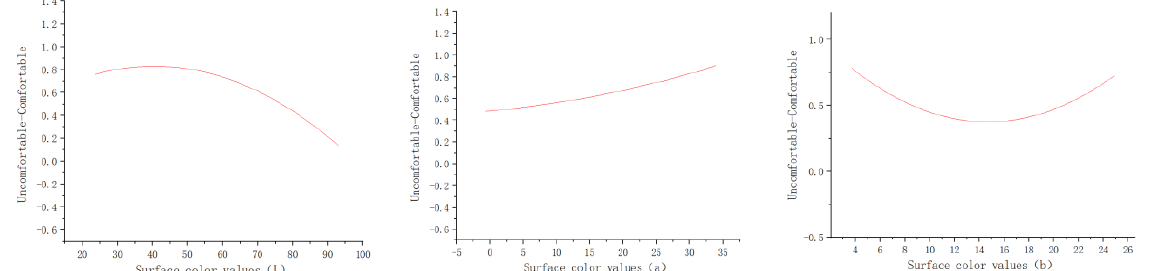
Figure 18. “Dull-Lively” and surface colour polynomial fitting function.